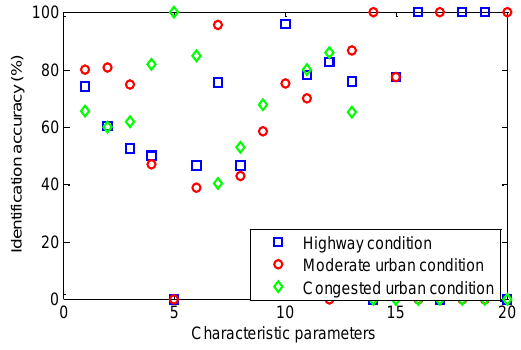
Figure 11. Identification accuracy based on sole characteristic parameter. Figure 10. Comparison histograms of part characteristic parameters. Figure 10. Comparison histograms of part characteristic parameters.